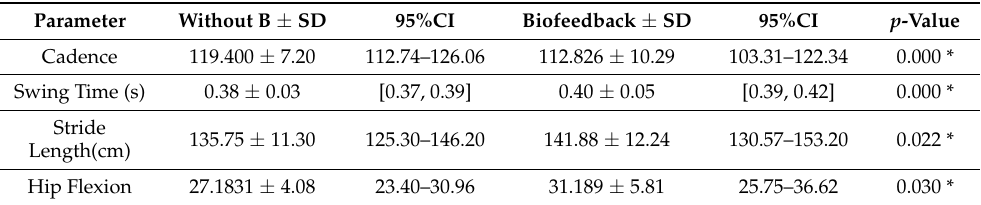
Table 1. Primary outcome variables in spatio-temporal parameters and peak joint angle comparing with and without the presence of